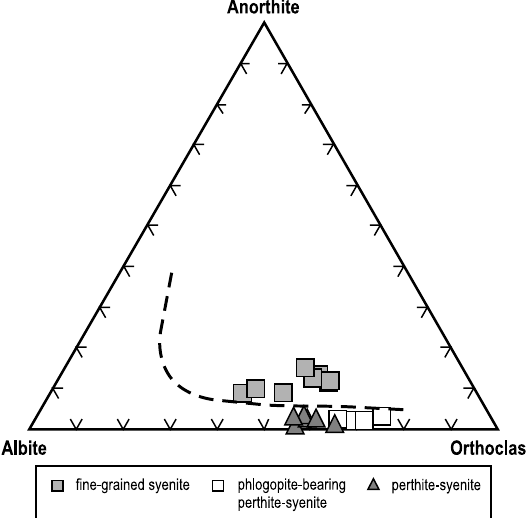
Fig. 4 – Syenitic rocks plotted in the Ab-An-Or normative diagram. Dashed